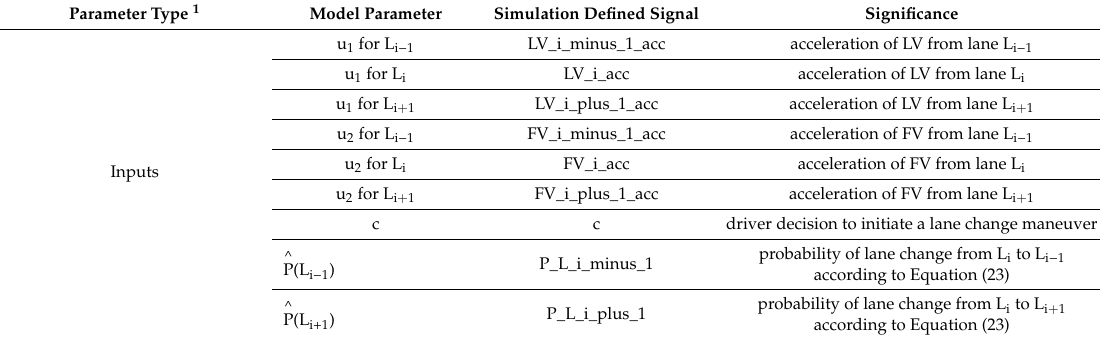
Table A1. Mapping between model parameters and simulation defined